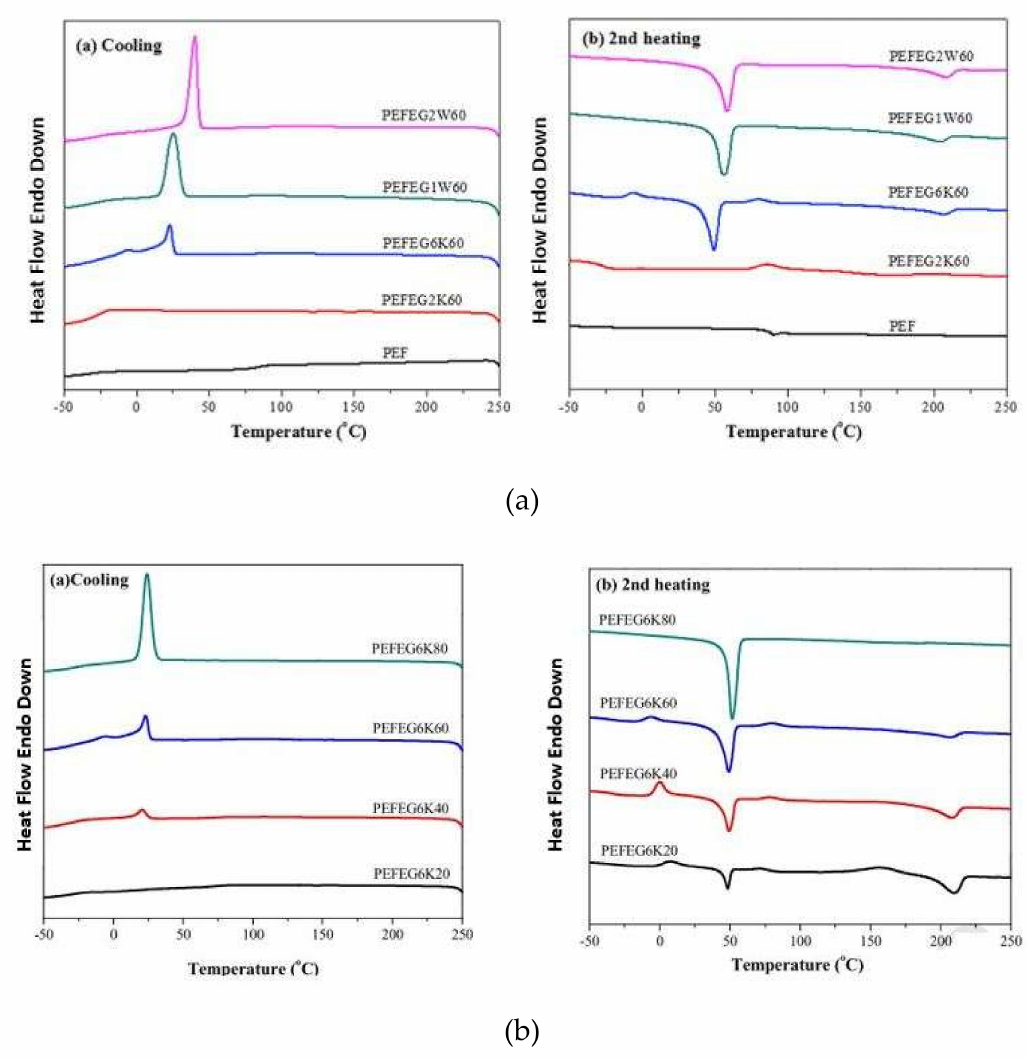
Figure 3. Thermal transitions of PEF- co -PEG copolymers: ( a ) fixed ester:ether ratio 40:60, increasing the molecular weight of PEG from 2 K to 20 K, ( b ) fixed molecular weight of PEG at 6 K, increasing the ester:ether ratio from 80:20 to 20:80